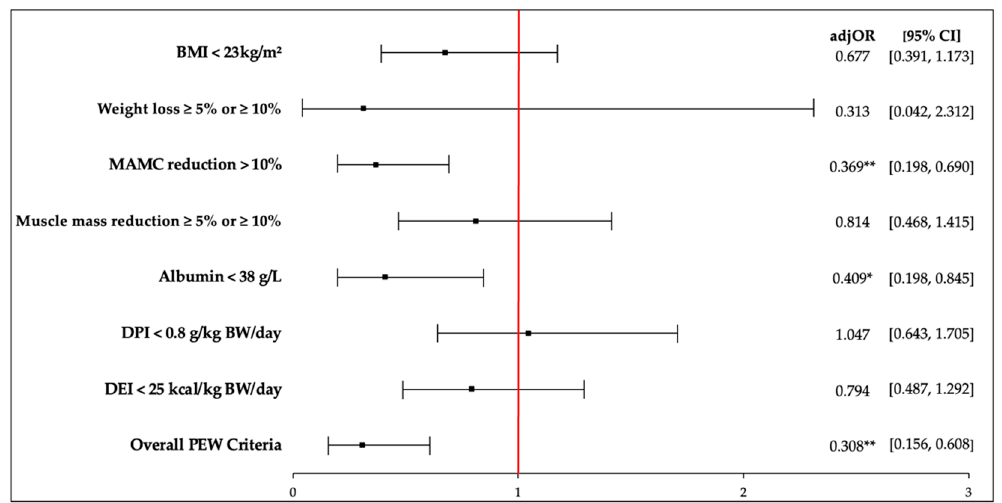
Figure 1. Forest plot for adjusted odds ratio of PhA as per PEW criteria according to ISRNM. Abbreviations: adjOR, adjusted odds ratio; BMI, body mass index; MAMC, mid-arm muscle circumference; DPI, dietary protein intake; DEI, dietary energy intake; PEW, protein energy wasting. OR was adjusted for age, gender, ethnicity, education level, marital status, employment, monthly income, comorbidities, dialysis vintage, and Kt/V. The red line represents odds ratio value of 1 (no association). Serum cholesterol and body fat percentage were not included as the expected frequency had less than five representative cases. * p < 0.05, ** p < 0.01.